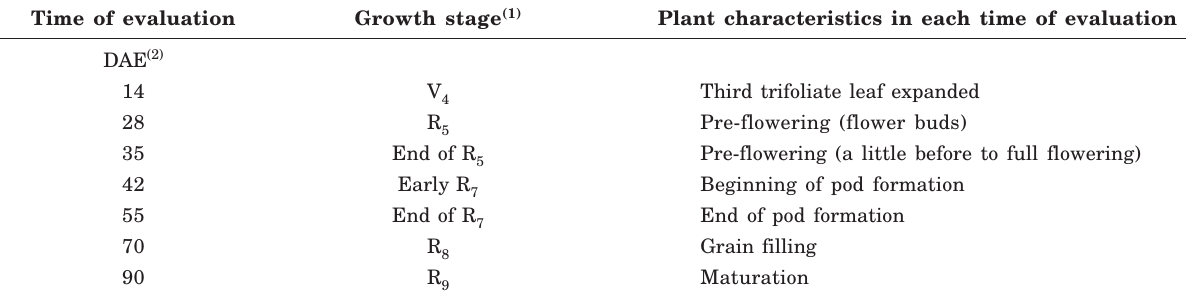
(1) Fernández et al. (1986). (2) Days after emergence.